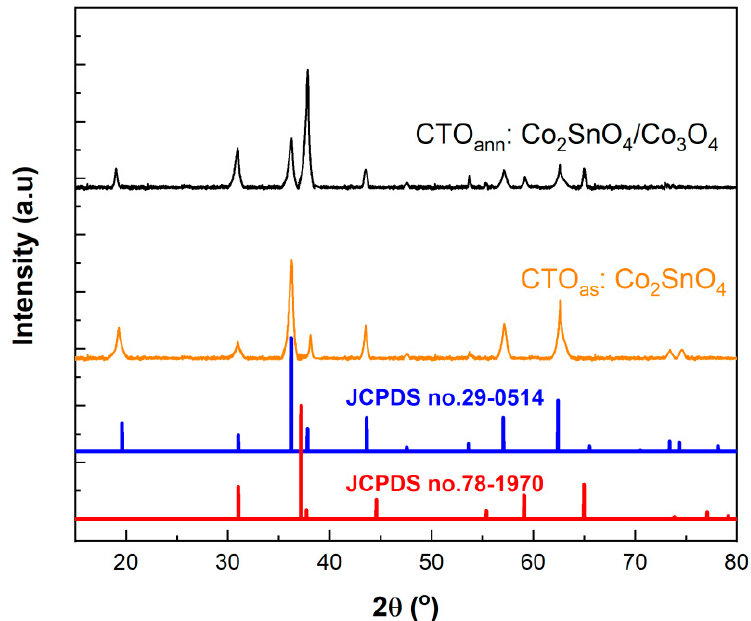
Figure 3. XRD pattern of the as-prepared (CTO as ) and annealed (CTO ann ) Co 2 SnO 4 films.